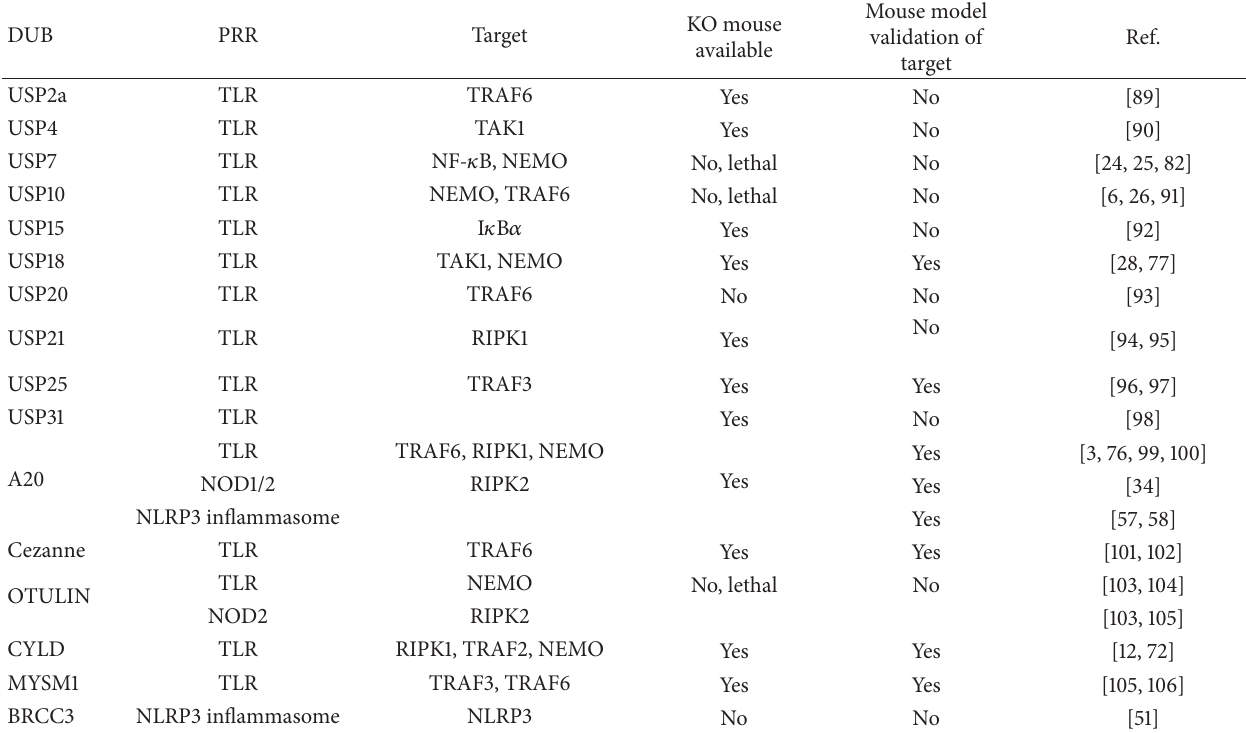
Table 1: DUBs involved in TLR, NOD1/2, or inflammasome activation. Knock-out mouse available for these DUBs has been indicated. Mouse model validation of target in which these mice have been used to demonstrate their function on that substrate. This table does not include studies where these mice have been used in other models of inflammation. DUB PRR Target